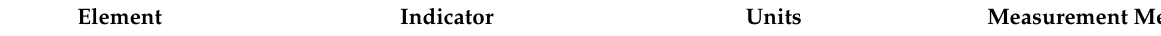
Table 4. Selected indicators and their measurement